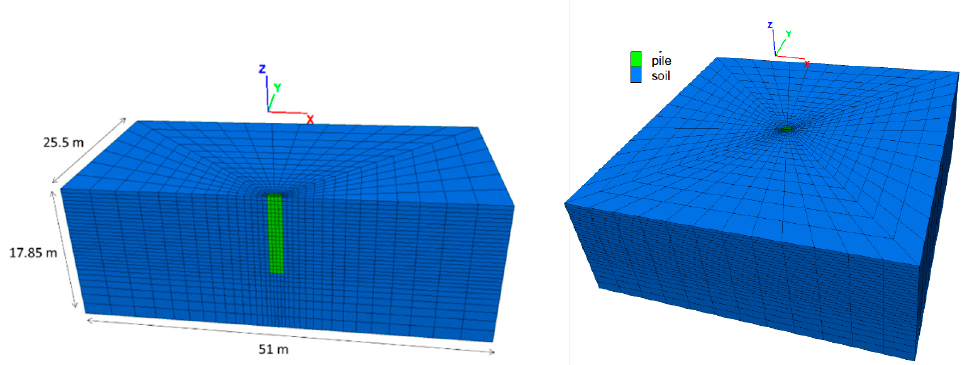
Figure 5. Numerical models for the mono-directional lateral loading (left) and multi-directional lateral loading (right).